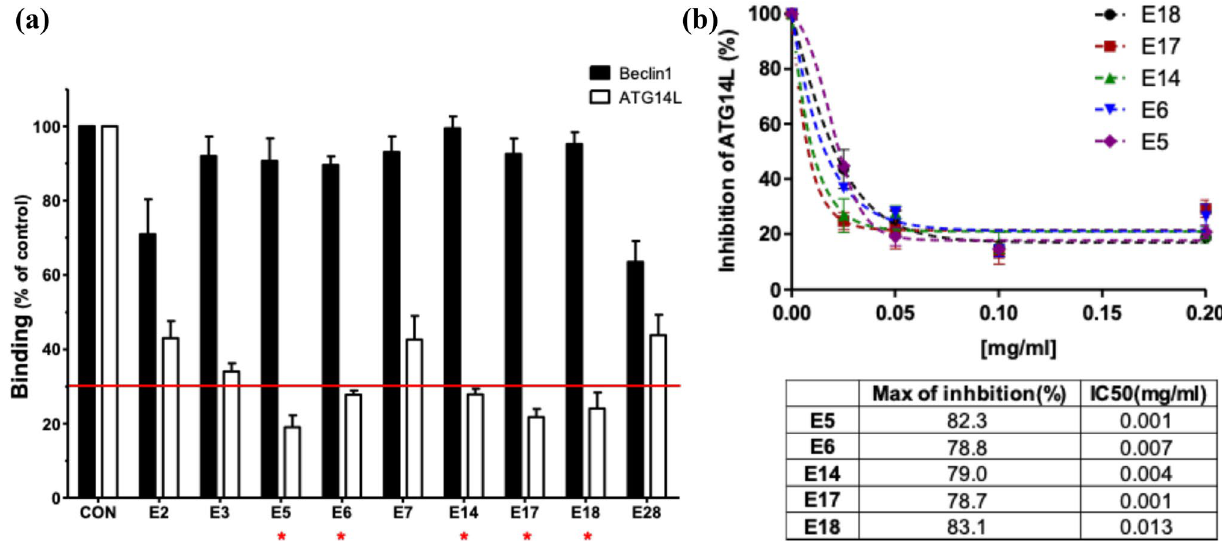
Figure 2. The second round screening and the analysis of inhibition potency of the hit extracts. ( a ) Second in vitro Vps34-Beclin 1-ATG14L complex formation assay. The same experiment shown in Fig. 1B was repeated against nine candidate extracts from the first round screening (E2, E3, E5, E6, E7, E14, E17, E18, and E28) at fourfold diluted condition (0.05 mg/ml). The relative ATG14L or Beclin 1 bindings are represented as % of the control with 0.25% DMSO instead of the extract. * denotes the candidates that passed the cut-off. ( b ) The kinetic analysis for the inhibition of ATG14L binding to the complex core unit, Vps34-Beclin 1. The complex formation assay was carried out against the five extracts that were satisfied with the cut-off on ( a ). The ELISA assays against both ATG14L and Beclin 1 were conducted in a manner dependent of the concentration of the five extracts. The ELISA results were plotted and analyzed their maximum inhibition (%) and IC50 by Prism GraphPad program v5. All data are obtained from the experiments in